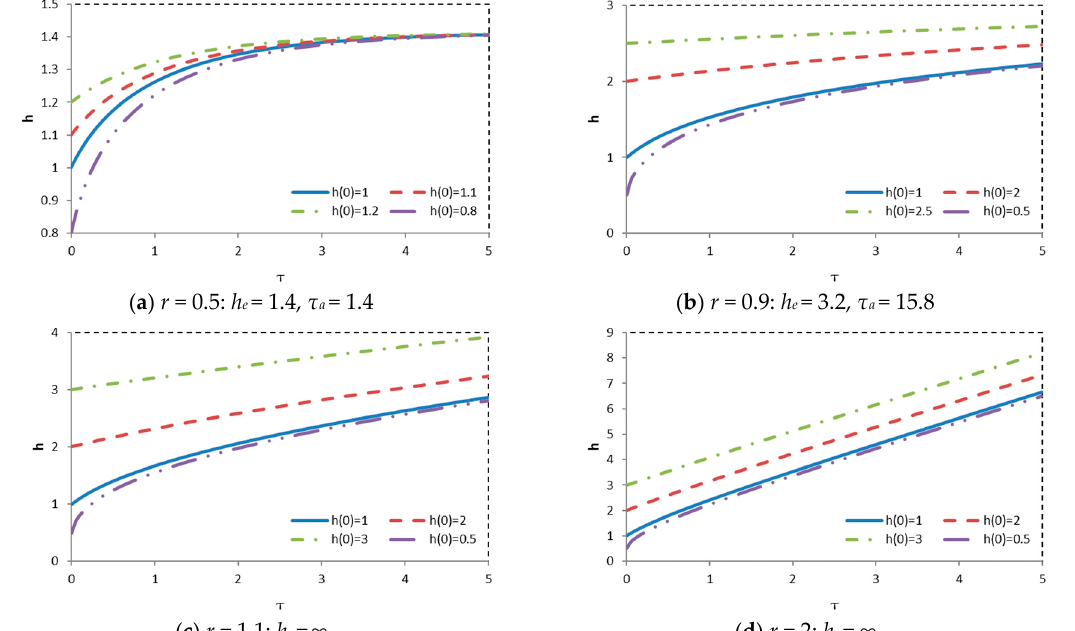
Figure 6. Transient development starting from various initial conditions (h(0)) for four SLR rates: ( a ) r = 0.5 (SLR far below critical rate), ( b ) r = 0.9 (SLR just below critical rate), ( c ) r = 1.1 (SLR just above critical rate), ( d ) r = 2 (SLR far above critical rate), in all cases n = 2. The dynamic equilibrium h e and the morphological timescale τ a are given in the title of the panels.